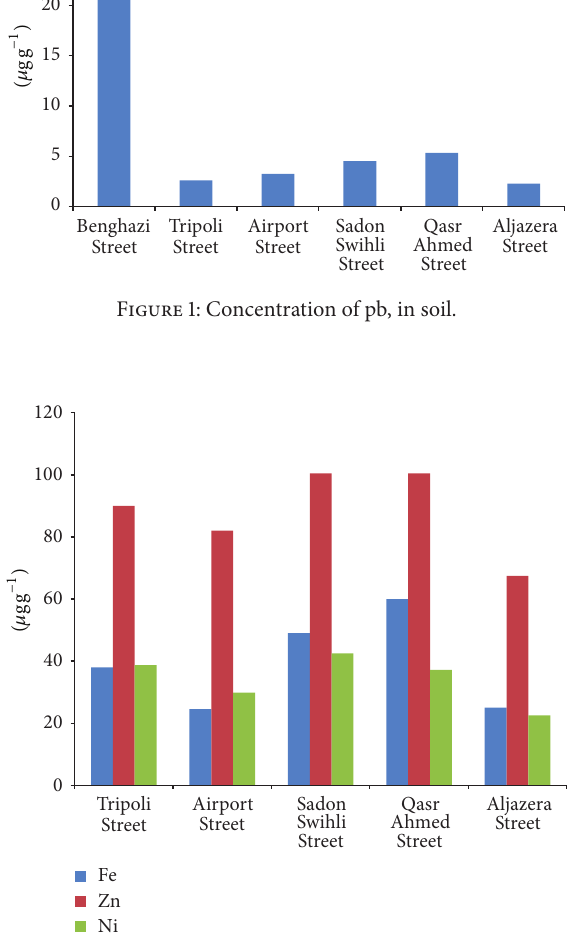
Figure 2: Concentration of Fe, Zn, and Ni in soil.